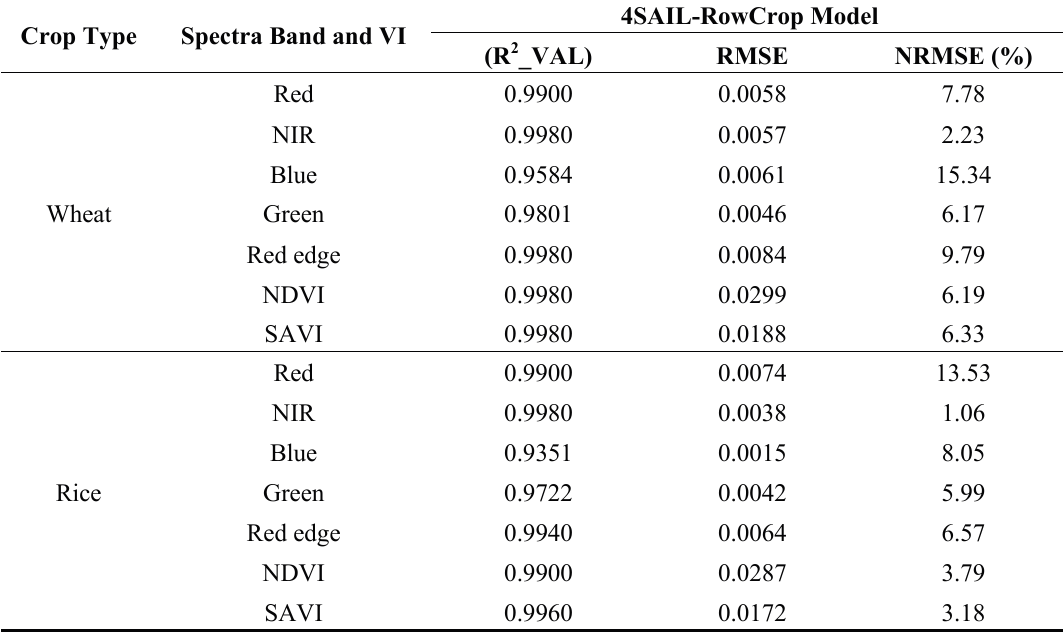
Table 11. The correlation of the simulated nadir reflectance spectra determined using the 4SAIL-RowCrop with field